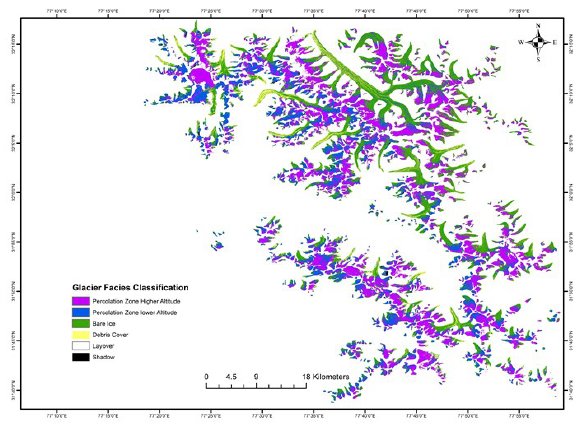
Figure 12. Classified radar zones or facies for upper Chenab, Beas basins as derived from SAR composite for year 2015.